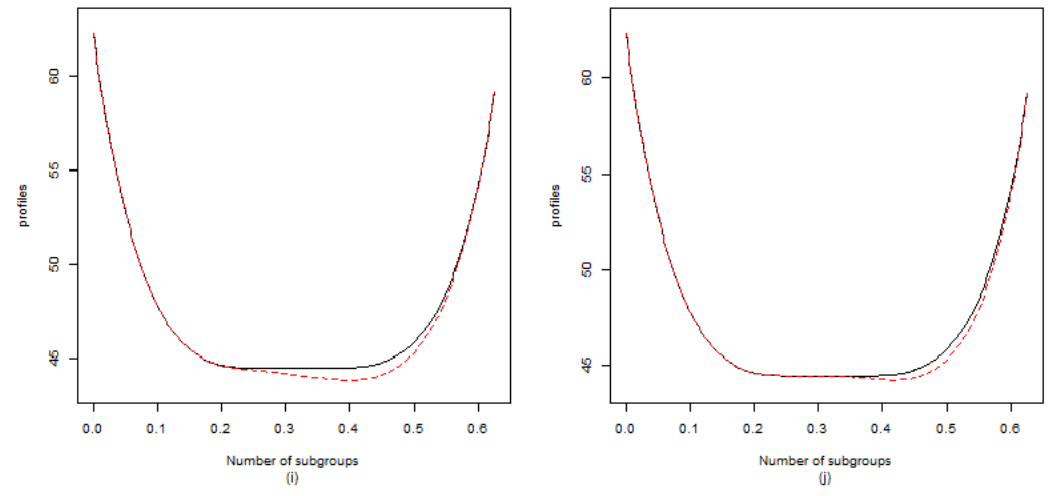
Figure 2. The reference profile (solid line) and the out-of-control profile (dash line) ( a ) Shift 1 ( b ) Shift 2